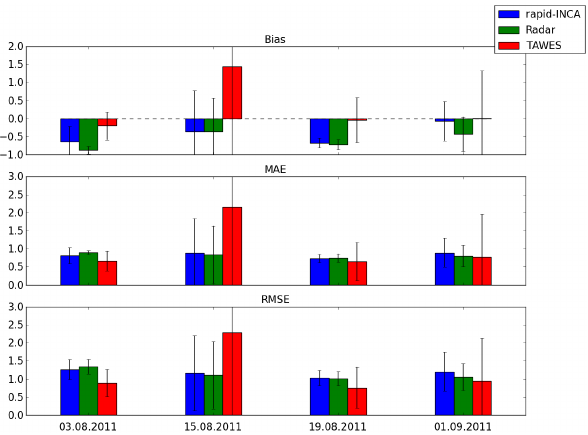
Figure 8. Relative bias, MAE and RMSE (weighted by the mean observed precipitation of WegenerNet). Values have been computed for each of the WegenerNet stations (151 stations) and then aver- aged over space. Error bars represent the standard deviation of ob- tained verification measures at each WegenerNet station.